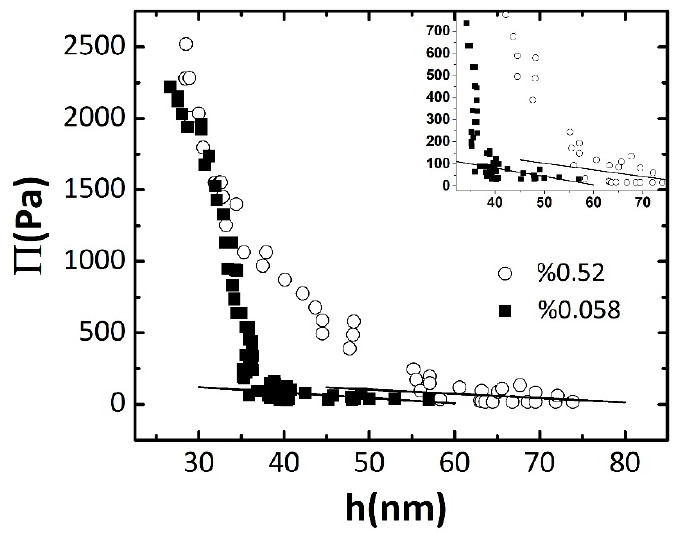
Figure 4. Disjoining pressure vs. film thickness for films A and B. A straight line is fitted to the experimental data to obtain the derivative of the disjoining pressure.